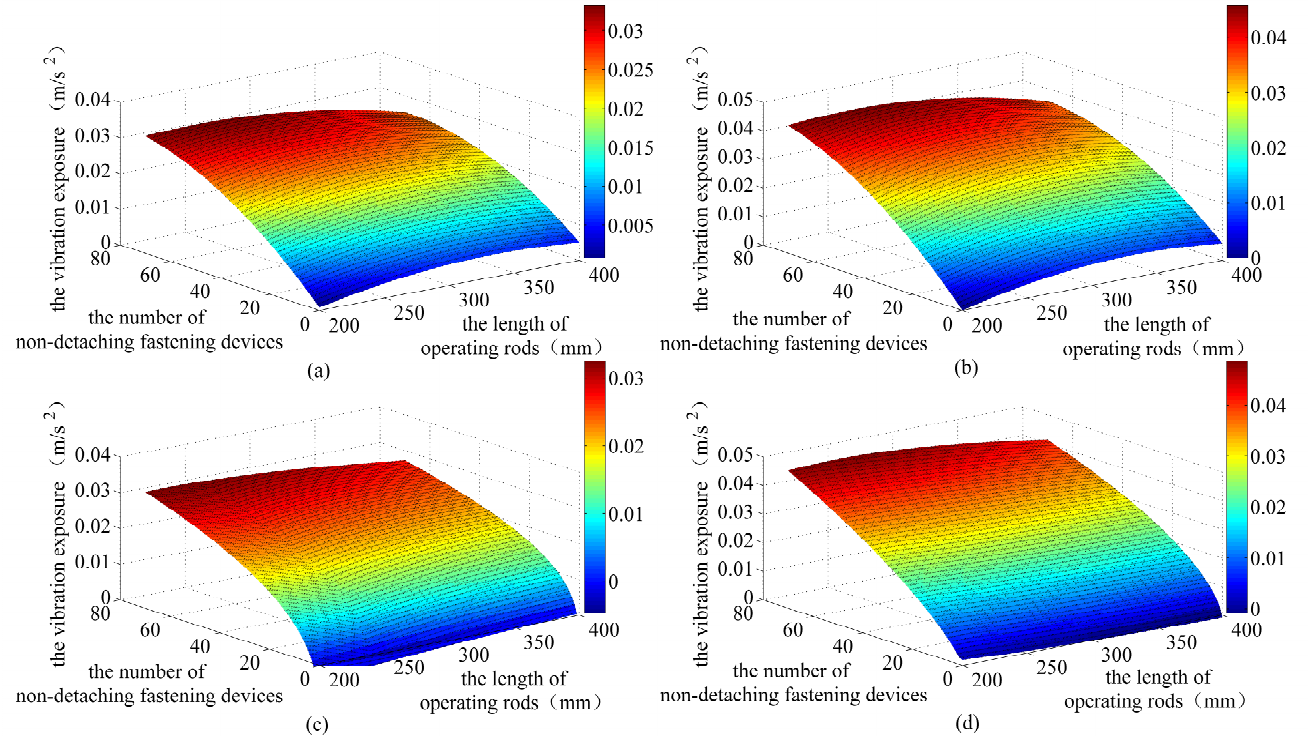
Figure 5. Comparison of prediction models for the vibration exposure as a function of the length of the operating rod and the number of the non-detaching fastening device: ( a ) Palm polynomial model; ( b ) Opisthenar polynomial model; ( c ) Palm nonlinear model; ( d ) Opisthenar nonlinear